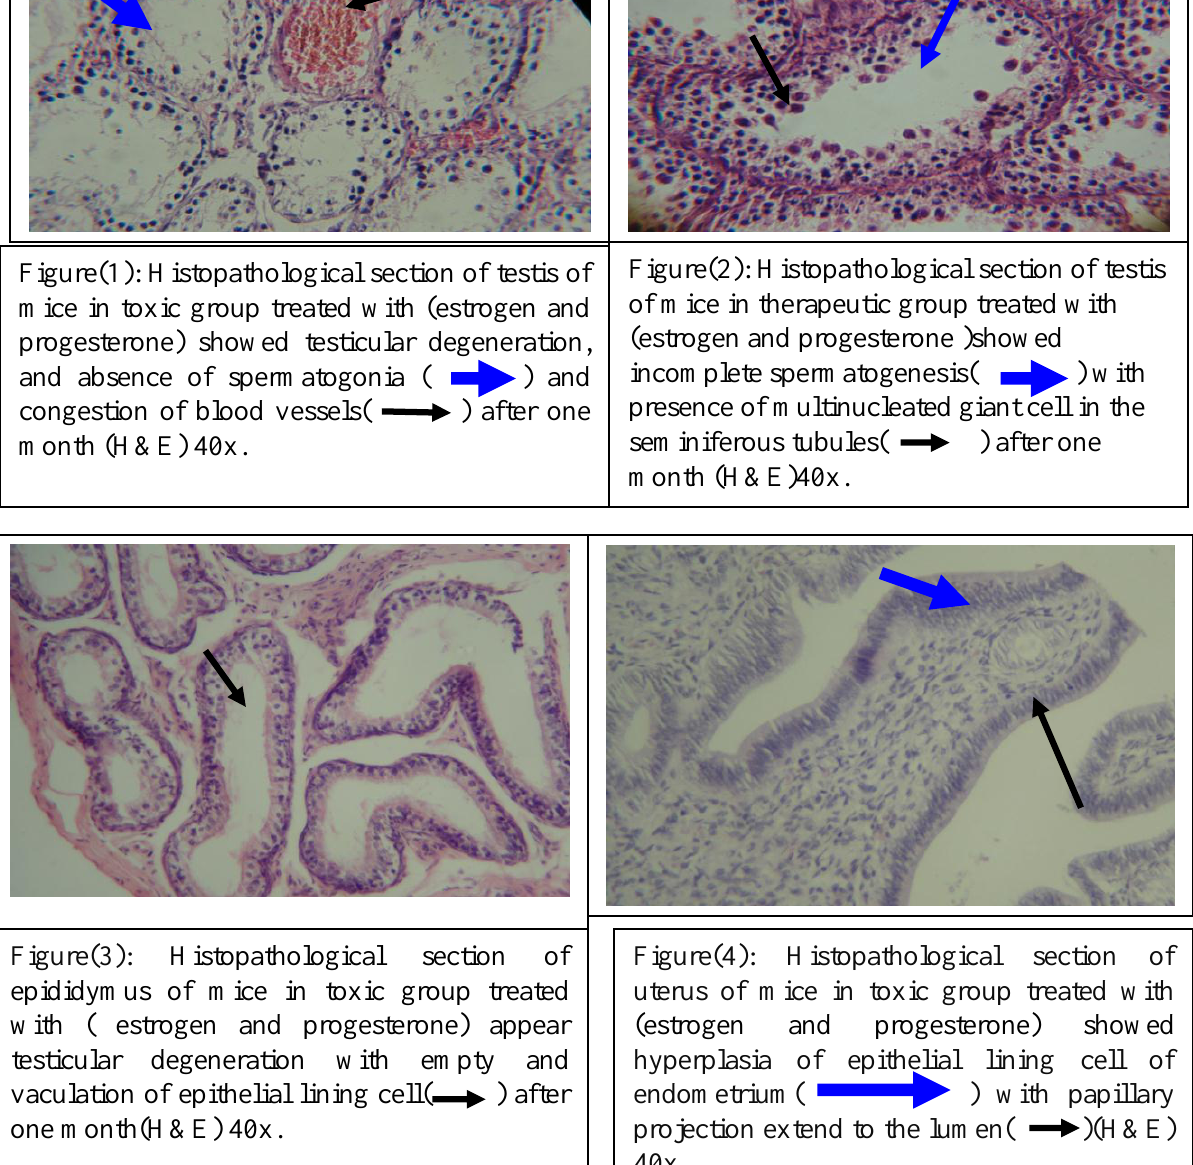
Figure(3): Histopathological section of epididymus of mice in toxic group treated with ( estrogen and progesterone) appear testicular degeneration with empty and vaculation of epithelial lining cell( ) after one month(H&E) 40x.